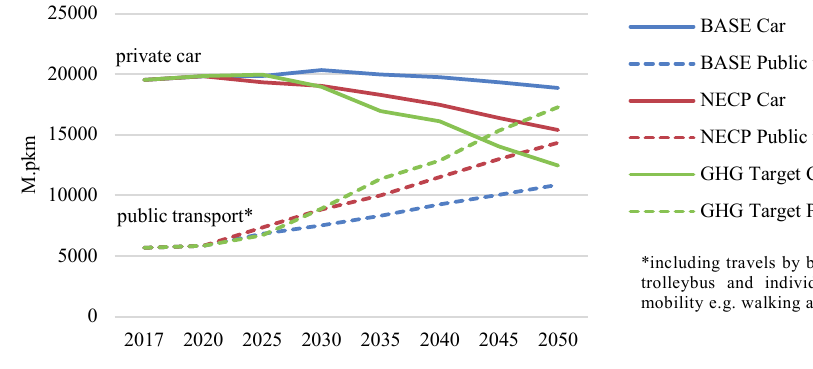
Fig. 13. Use of private cars and greener mobility for alternative scenarios